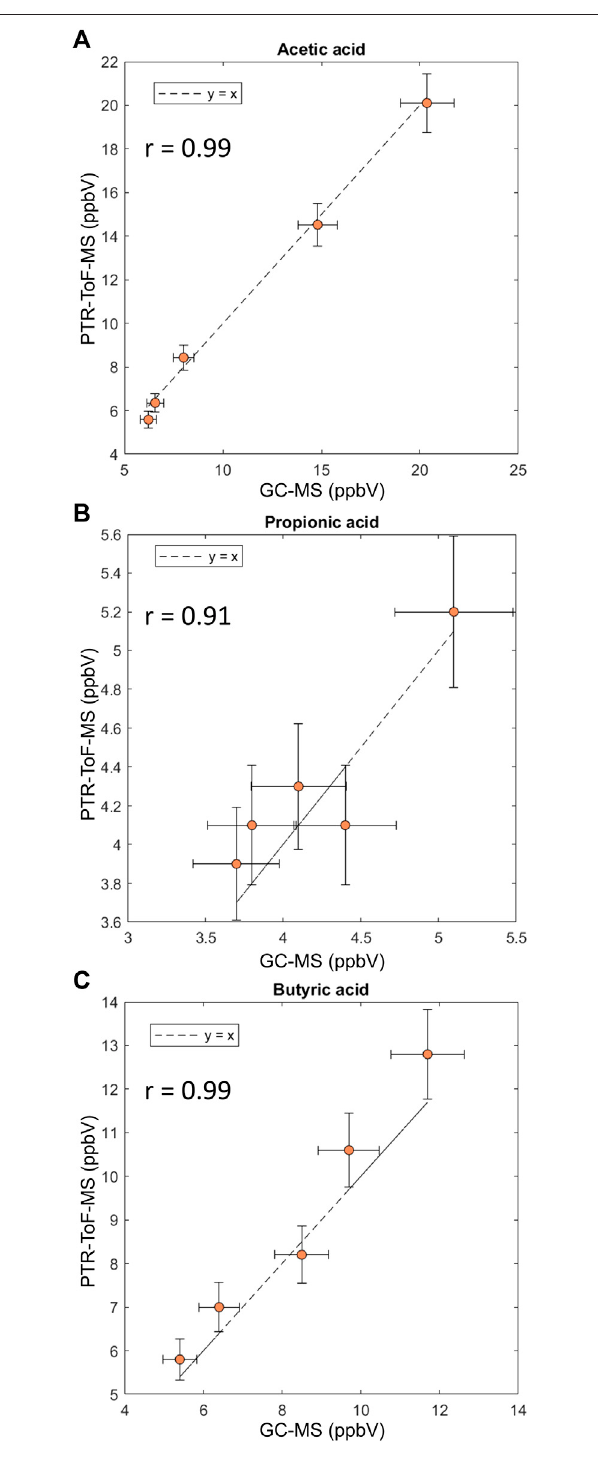
FIGURE 4 | Correlation plots for comparison of quanti fi cation of SCFAs with GC-MS and PTR-ToF-MS. (A) Acetic acid, (B) propionic acid and (C) butyric acid. Measurements were done in triplicate. Error bars represent the standard deviation.